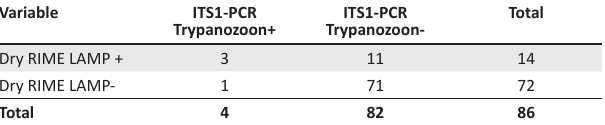
1-polymerase chain reaction for the detection of trypanosomes.